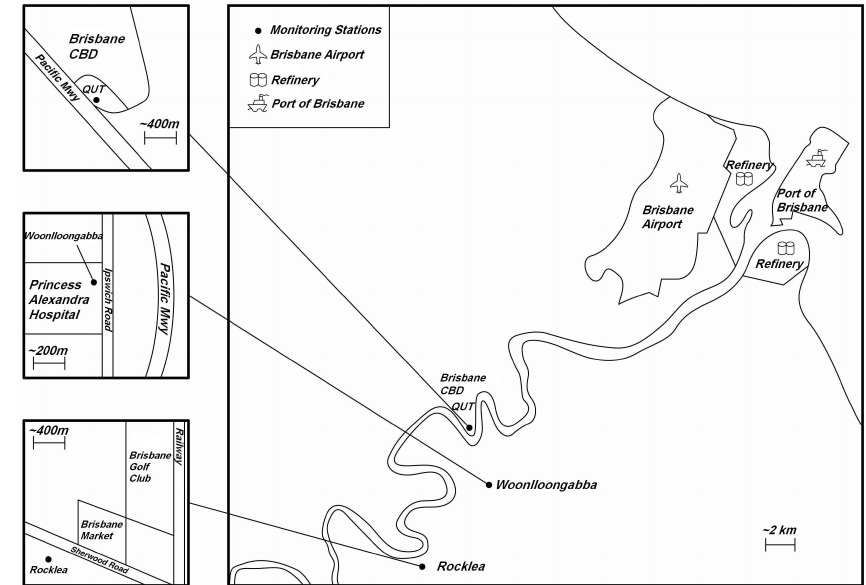
Fig. 1. Map of monitoring